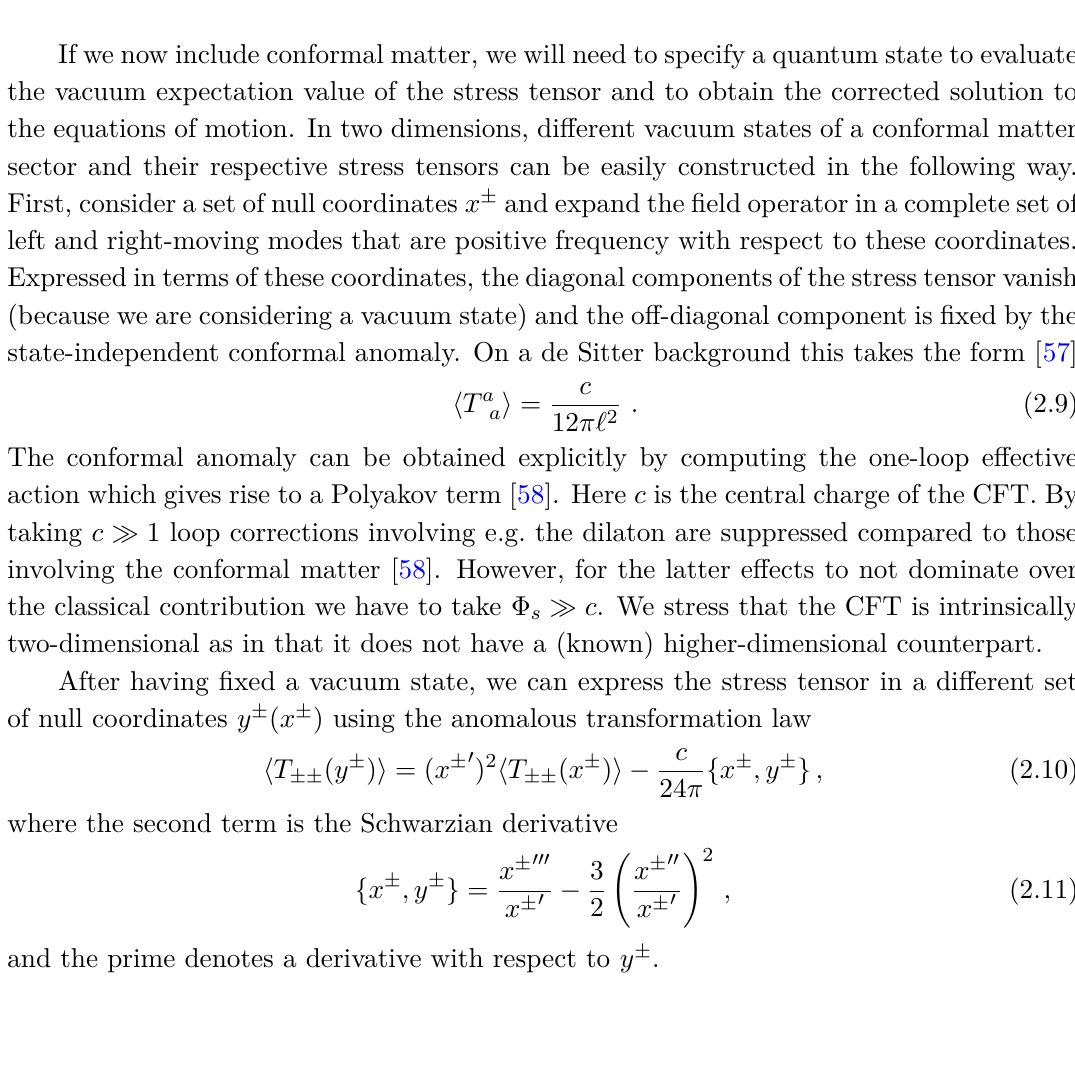
Figure 3 . Penrose diagram of two-dimensional de Sitter space obtained as a full reduction in the near-horizon limit of a Nariai black hole in four dimensions. The static coordinates (2.6) cover the two static patches shaded in blue and the coordinates x ± (see (2.15)) cover both the blue and orange shaded regions. The white regions are the black hole interior and the places where Φ → −∞ are its singularities. The left and right vertical lines of the diagram are